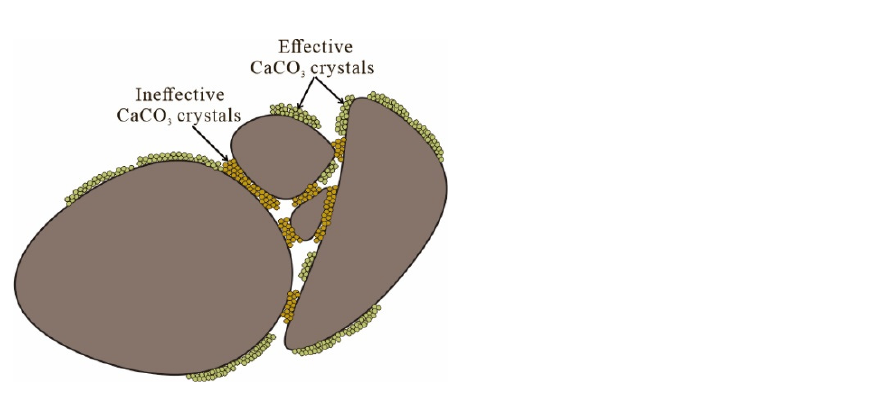
Figure 9. SEM images of MICP-treated sand (A1 and B1).